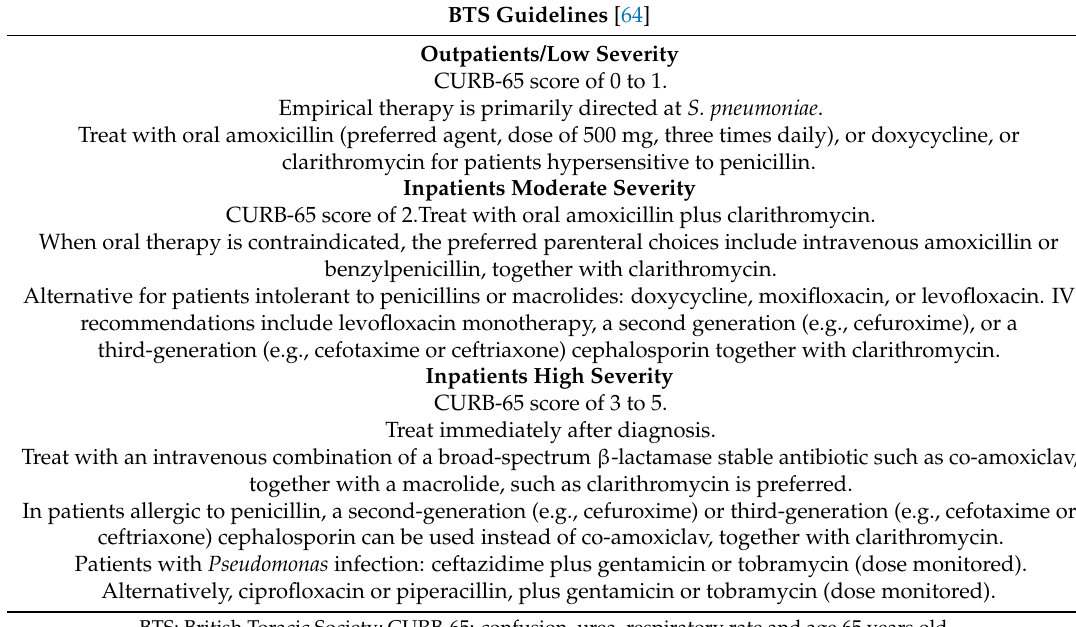
Table 4. Guidelines for the Management and Treatment of Community-Acquired